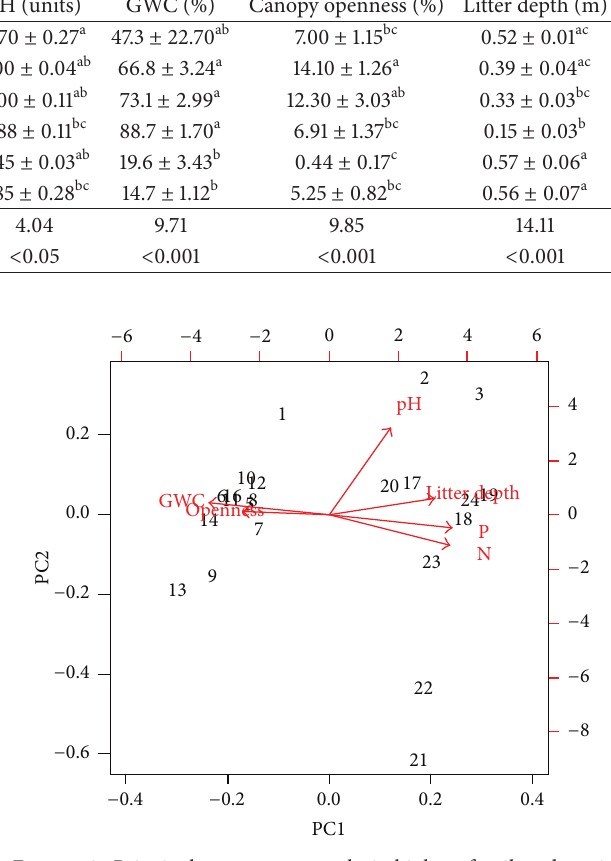
Figure 2: Principal component analysis biplot of soil and envi- ronmental variables in 24 subplots in the Tutong White Sands.